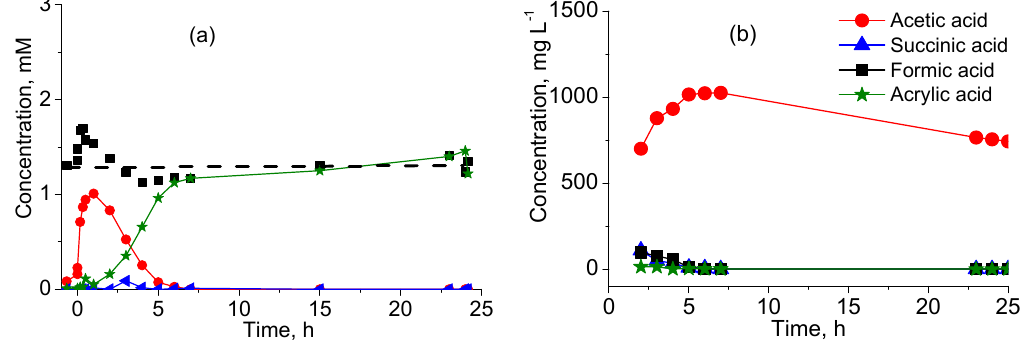
Figure 2. Evolution of: ( a ) Total Organic Carbon (TOC) and ( b ) concentrations of Total Nitrogen (TN) Figure 5. First recycling of Ru / TiO 2 catalyst in the Catalytic Wet Air Oxidation (CWAO) of diluted VBC (measured by TOC-TN apparatus) and different N-species (analyzed by ionic chromatography) Figure 5. First recycling of Ru/TiO 2 catalyst in the Catalytic Wet Air Oxidation (CWAO) of diluted at 190 ◦ C under 70 bar: ( a ) concentrations of N-species; TN ( (cid:4) ), NH 4 + ( (cid:8) ), NO 3 − ( during oxidation of diluted VBC in the absence of a catalyst: TN ( ■ ), NH 4+ ( • ), NO 3- (  ), and NO 2- ( 7 VBC at 190 °C under 70 bar: ( a ) concentrations of N-species; TN ( ■ ), NH 4+ ( • ), NO 3- (  ) and NO 2- ( ▲ ); and ( b ) concentrations of carboxylic (di)acids.